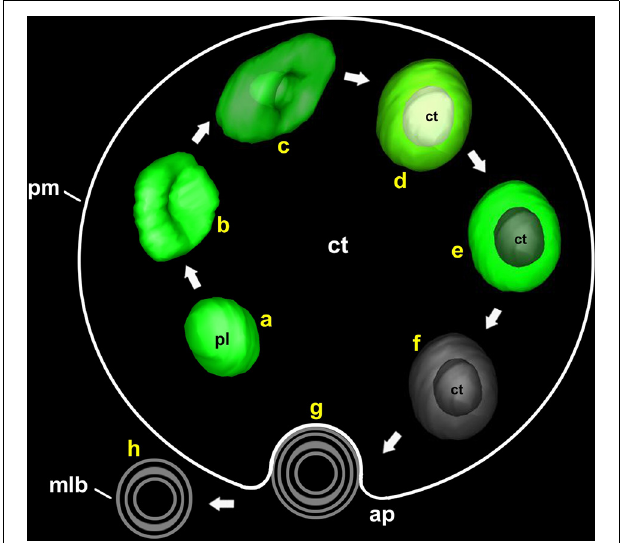
FIGURE 9 | Model of the different steps involved in the process of plastolysome formation and excretion to the apoplast. First, an initially conventional plastid (a) creates an invagination at its envelope (b). The invagination enters into the plastid until it wraps the cytoplasmic portion (c). Then, the plastid envelope closes around the cytoplasmic portion, isolating it from the outer cytoplasm (d). Once the cytoplasm is internalized, digestion of the cytoplasm (e) and then of the entire plastid (f) takes place. Finally, the remnants are excreted to the apoplast (g,h) in the form of a multilamellar body. ap, apoplast; ct, cytoplasm; mlb, multilamellar body; pl, plastid; pm, plasma